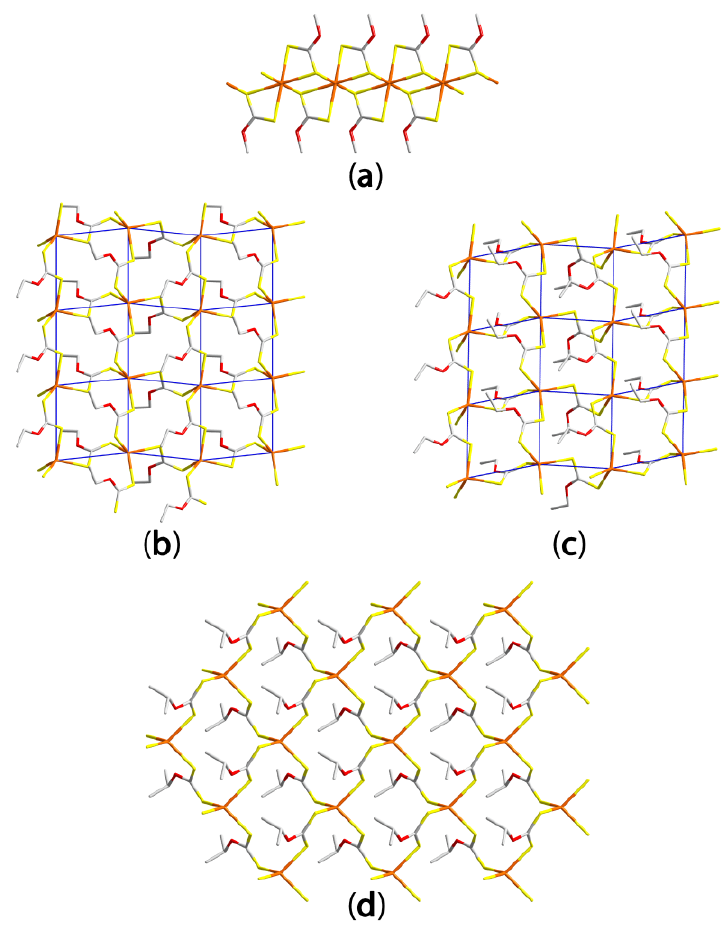
Figure 3. Aggregation in the crystals of ( a ) [Cd(S 2 COMe) 2 ] n ( 5 ); ( b ) [Cd(S 2 COEt) 2 ] n ( 6 ); ( c ) [Cd(S 2 COEt) 2 ] n ( 7 ); and ( d ) [Cd(S 2 CO-i-Pr) 2 ] n ( 8 ).